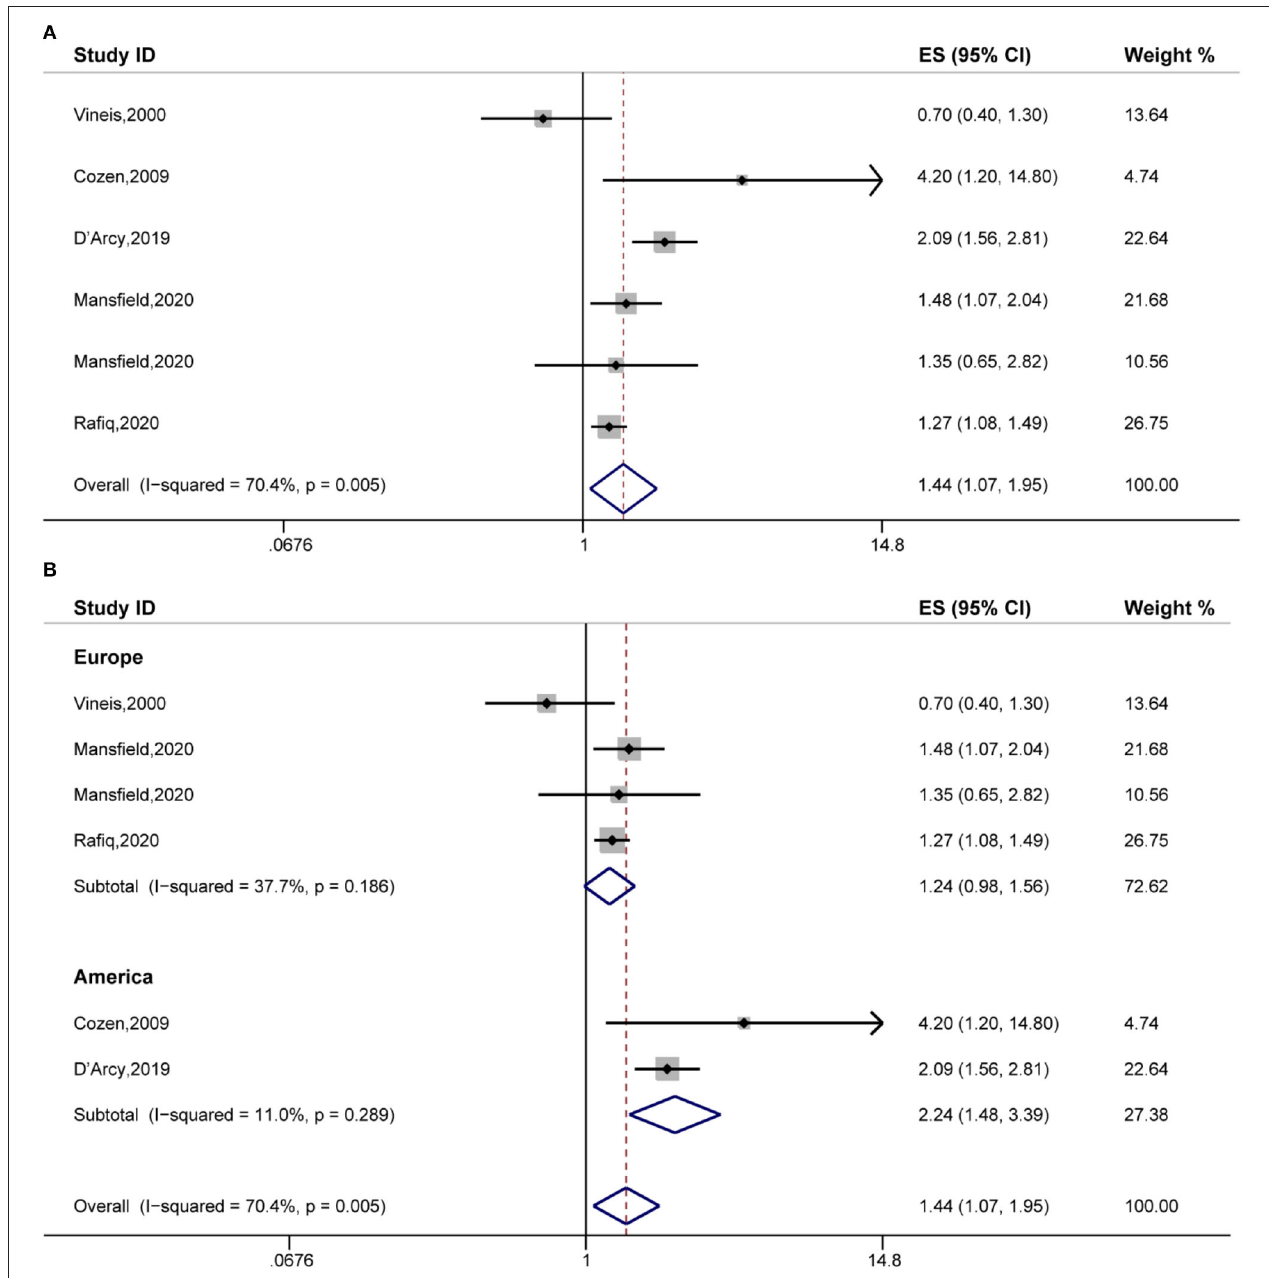
FIGURE 3 | The association between eczema and Hodgkin’s lymphoma risk. (A) Forest plot of the estimated effects of eczema on Hodgkin’s lymphoma risk. (B) Subgroup analysis of the estimated effects of eczema on Hodgkin’s lymphoma risk.